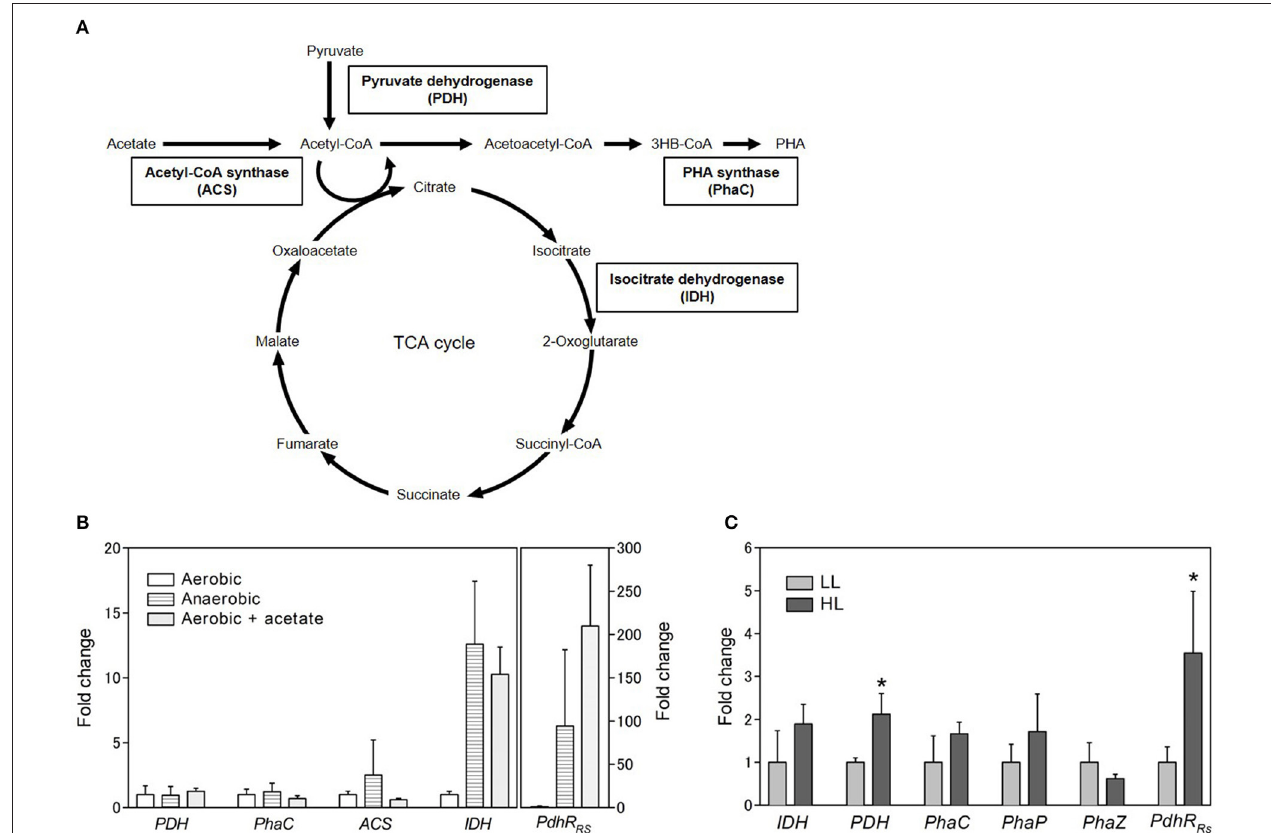
FIGURE 4 | Gene expression analysis. (A) Schematic representation of carbon metabolic pathway. (B) Gene expression analysis of selected genes under aerobic conditions with or without acetate and anaerobic conditions. The expression levels are shown as the relative values compared with those of cells grown aerobically. The rpoD gene was used as a housekeeping gene to normalize the expression levels of target genes. (C) Gene expression analysis under different light conditions. Cells were cultured in low (light gray bars; 8 W/m 2 : 800nm) and high (dark gray bars; 50 W/m 2 : 800nm) light for 3 days. Data are the mean ± SD from at least three cultures. * P <